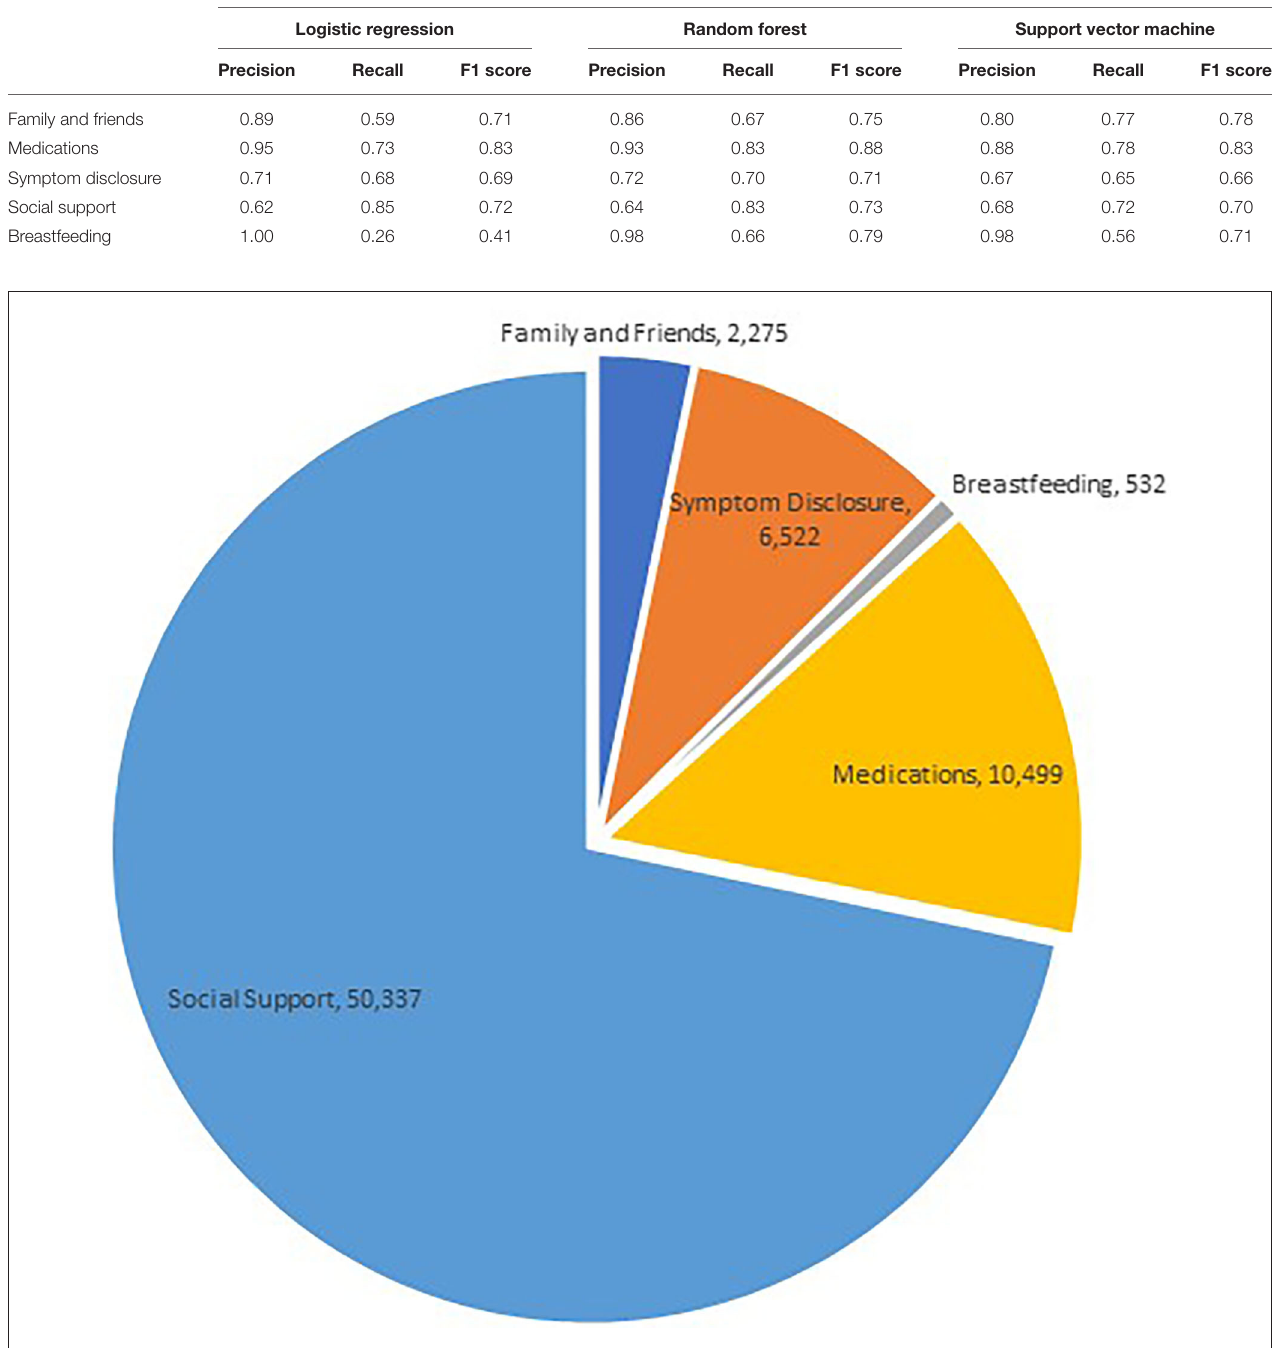
we found that positive emotions had the highest percentage of words in user posts ( Table 5 ). However, negative emotions did not fall far behind. Anxiety had a very low score, as did Anger. This may be indicative of the supportive nature of online PPD